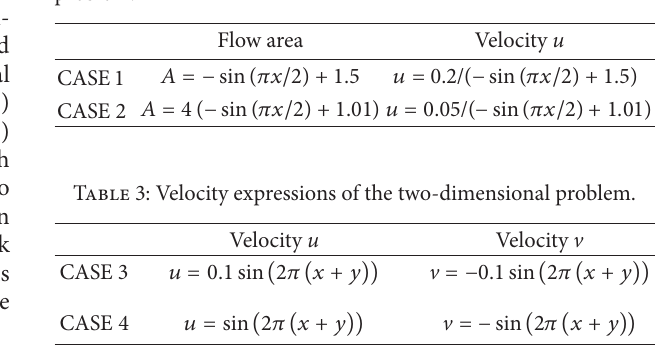
Table 2: Flow area and velocity expressions of the one-dimensional problem.